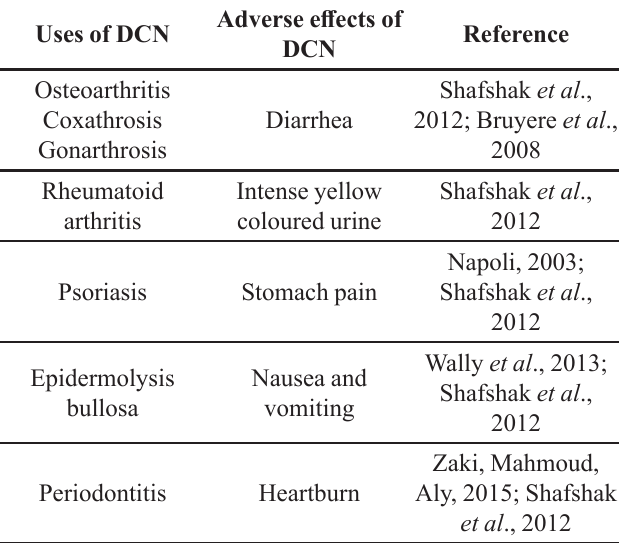
TABLE III - Interaction of DCN with other drugs Interaction with